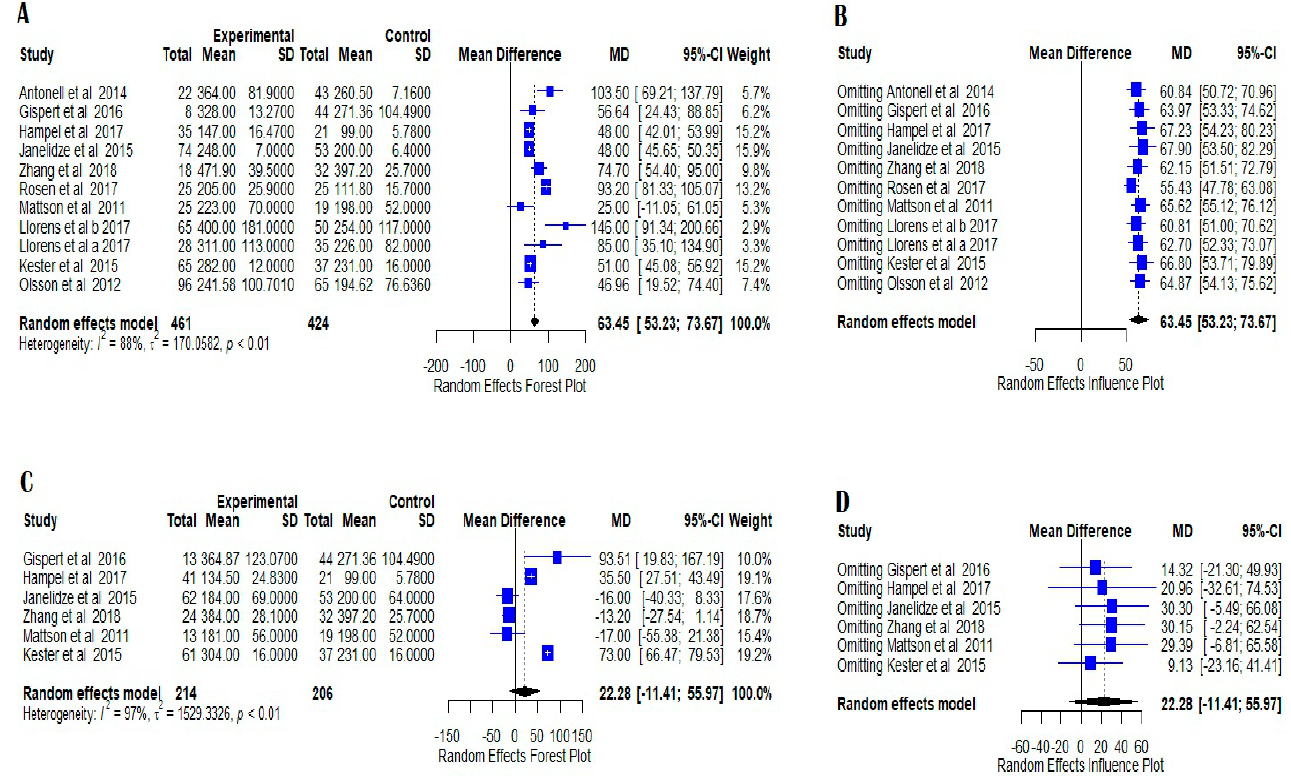
Figure 1. Forest plots of YKL-40 CSF levels in AD versus NC; ( A ) and MCI versus NC; ( C ) indicating high heterogeneity in random effect model and statistically significant differences between the compared groups. The figures indicate the means, standard errors (pg/mL), 95% confidence intervals, and weighted mean differences for each study included in this meta-analysis. For each comparison, a supplemental random effects influence plot was designed to further evaluate the possible publication bias when omitting each of the included studies ( B , D ), mean differences and 95% confidence intervals being calculated in each situation. No statistically significant impact was observed when omitting each of the evaluated studies. The standardized mean differences between patients and controls are represented as squares whose sizes are proportional to the sample sizes. The whiskers represent the 95% confidence intervals. The diamonds represent the pooled estimate based on the random-effect model with the center representing the point estimate and the width indicating the assessed 95% confidence interval. The heterogeneity indicators (I 2 , τ 2 , p ) are presented below each random effects Forest